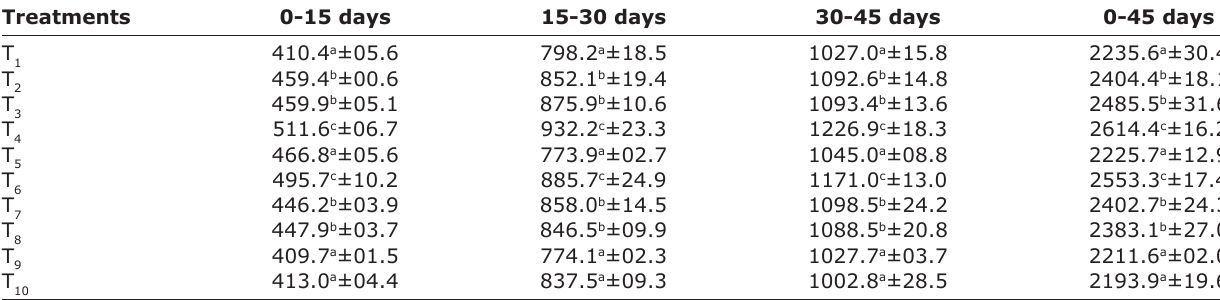
Table-6: Average weight gain (g/bird) during different growth periods under different dietary treatments. Treatments